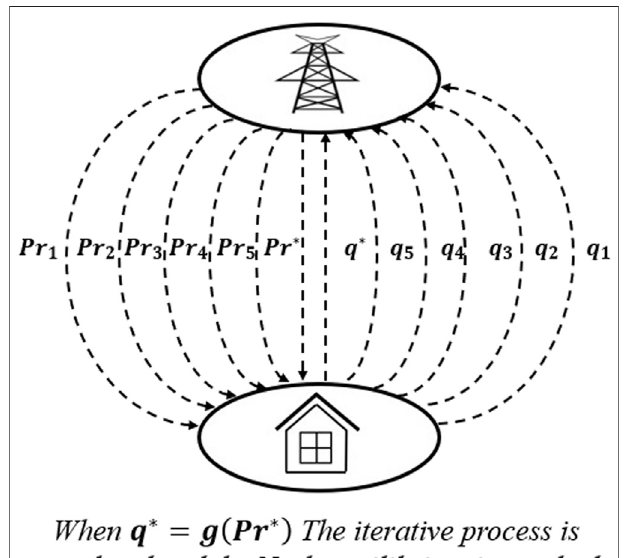
FIGURE 2 | Participant ’ s strategies converge when the game towards Nash